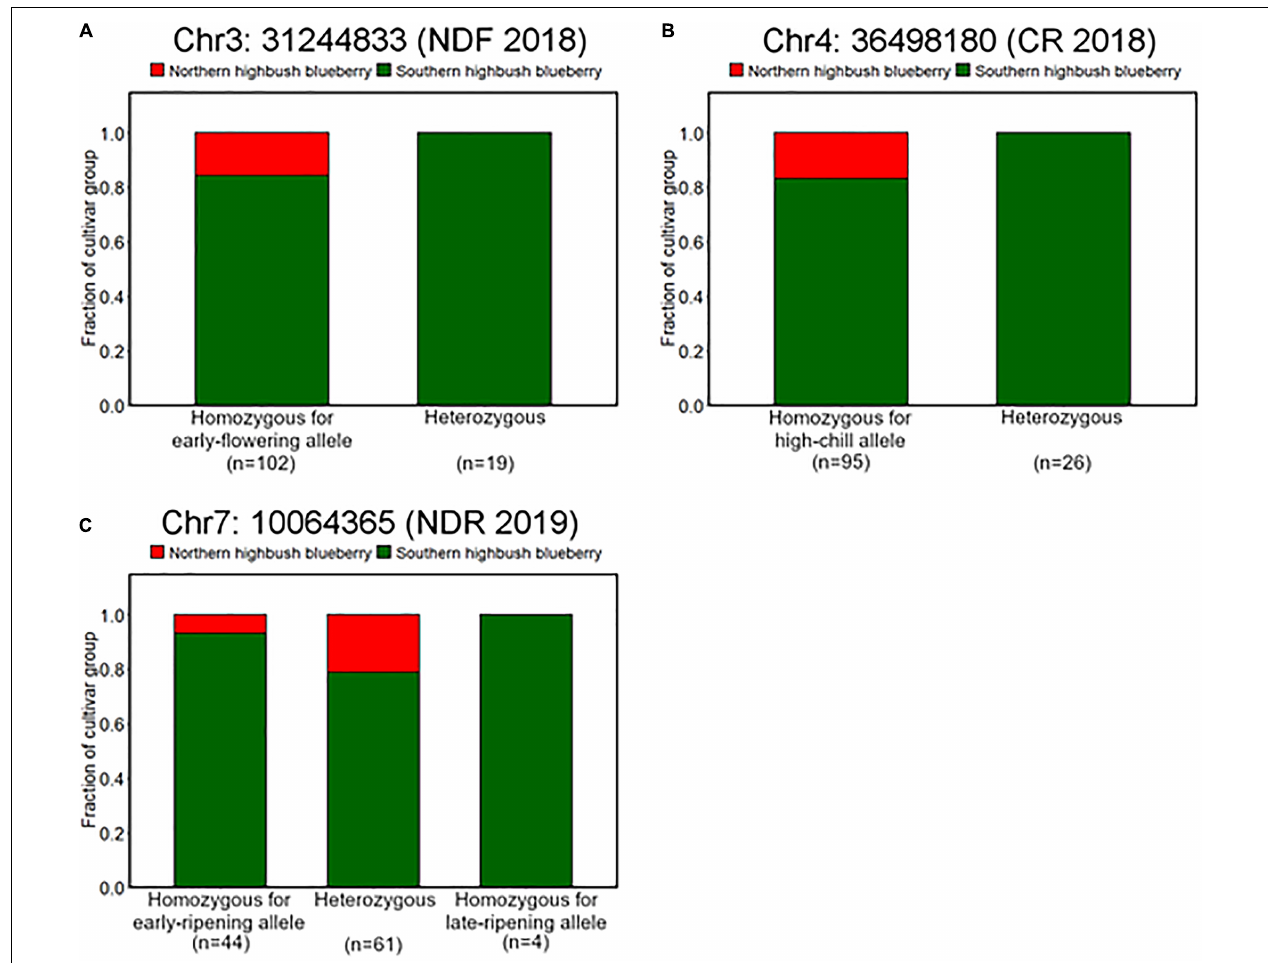
FIGURE 8 | Difference of allele frequencies at loci significantly associated with phenology traits between northern highbush blueberries (NHBs) and SHBs. Proportions of cultivar groups at loci significantly associated with (A) flowering date in 2018 (Chr3: 31244833), (B) CR in 2018–2019 season (Chr4: 36498180), and (C) ripening date in 2019 (Chr7: